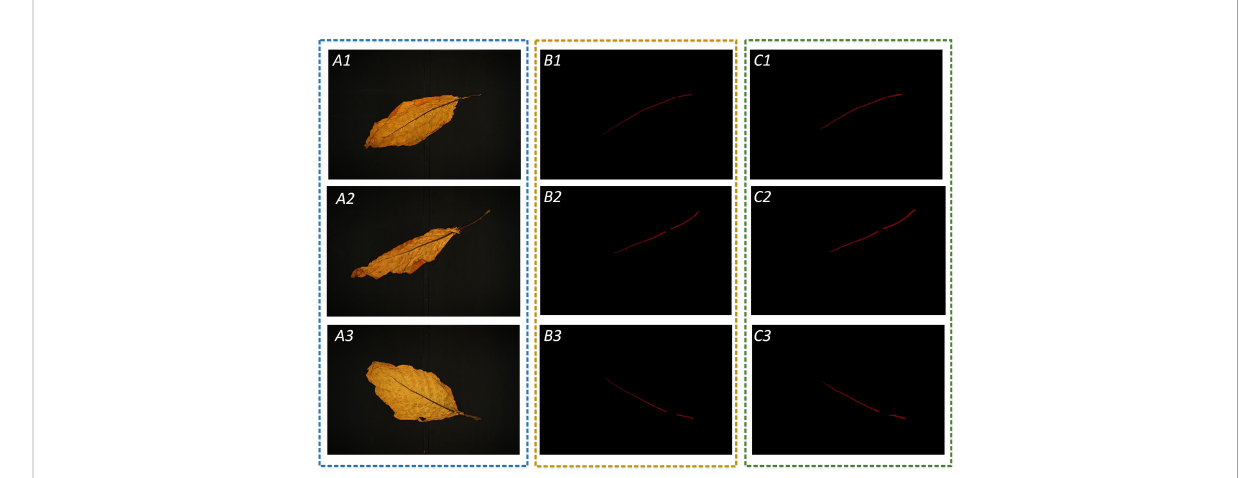
FIGURE 7 Test the result of leaf vein segmentation; A1, A2, and A3 are three images of fl ue-cured tobacco chosen at random; B1, B2, and B3 are manual annotations of leaf vein regions; and C1, C2, and C3 are the results of leaf vein segmentation using the MobileNetV2-DeepLabV3+.